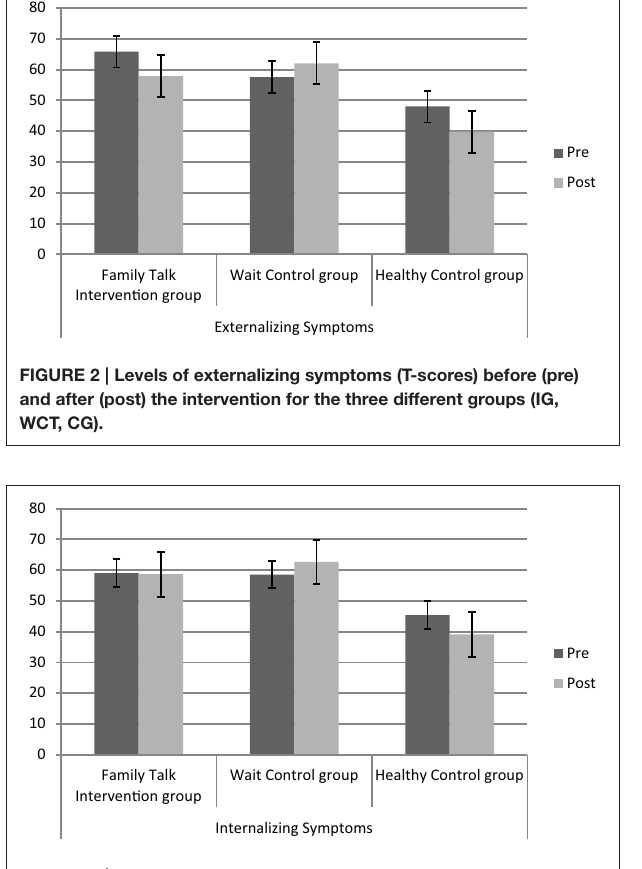
FIGURE 3 | Levels of internalizing symptoms (T-scores) before (pre) and after (post) the intervention for the three different groups (IG, WCT,